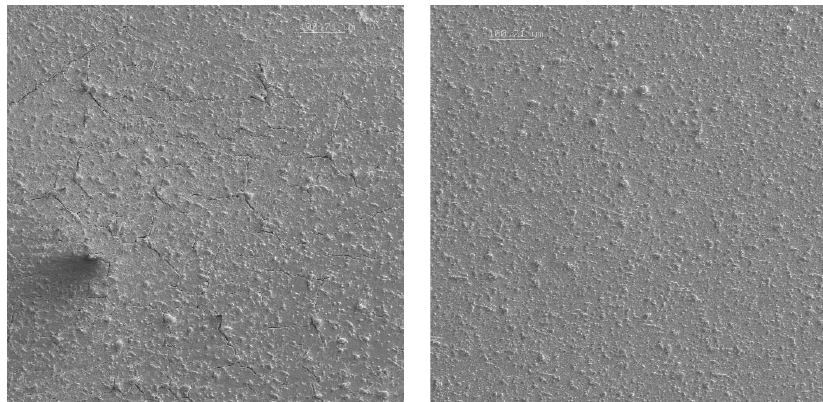
FIG. 18. Comparison snapshot of a region of maximum temperature rise on the left and a region of zero temperature rise on the right for one end cap. The length scale is 100 : 7 (cid:3) m .